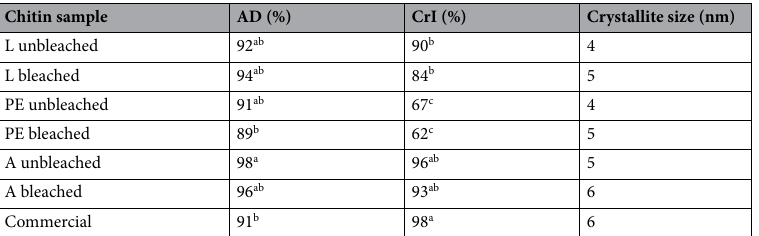
Table 5. Acetylation degree (AD %), crystallinity index (CrI) and crystallite size (nm) resulted from FTIR and XRD analysis of both bleached and unbleached chitin samples extracted from H. illucens larvae (L), pupal exuviae (PE) and dead adults (A) and a commercial chitin derived from crustaceans. Different letters in a column indicate significant differences ( p < 0.05) in the AD or CrI among chitin samples (data analyzed with Chi-square test with Yates’